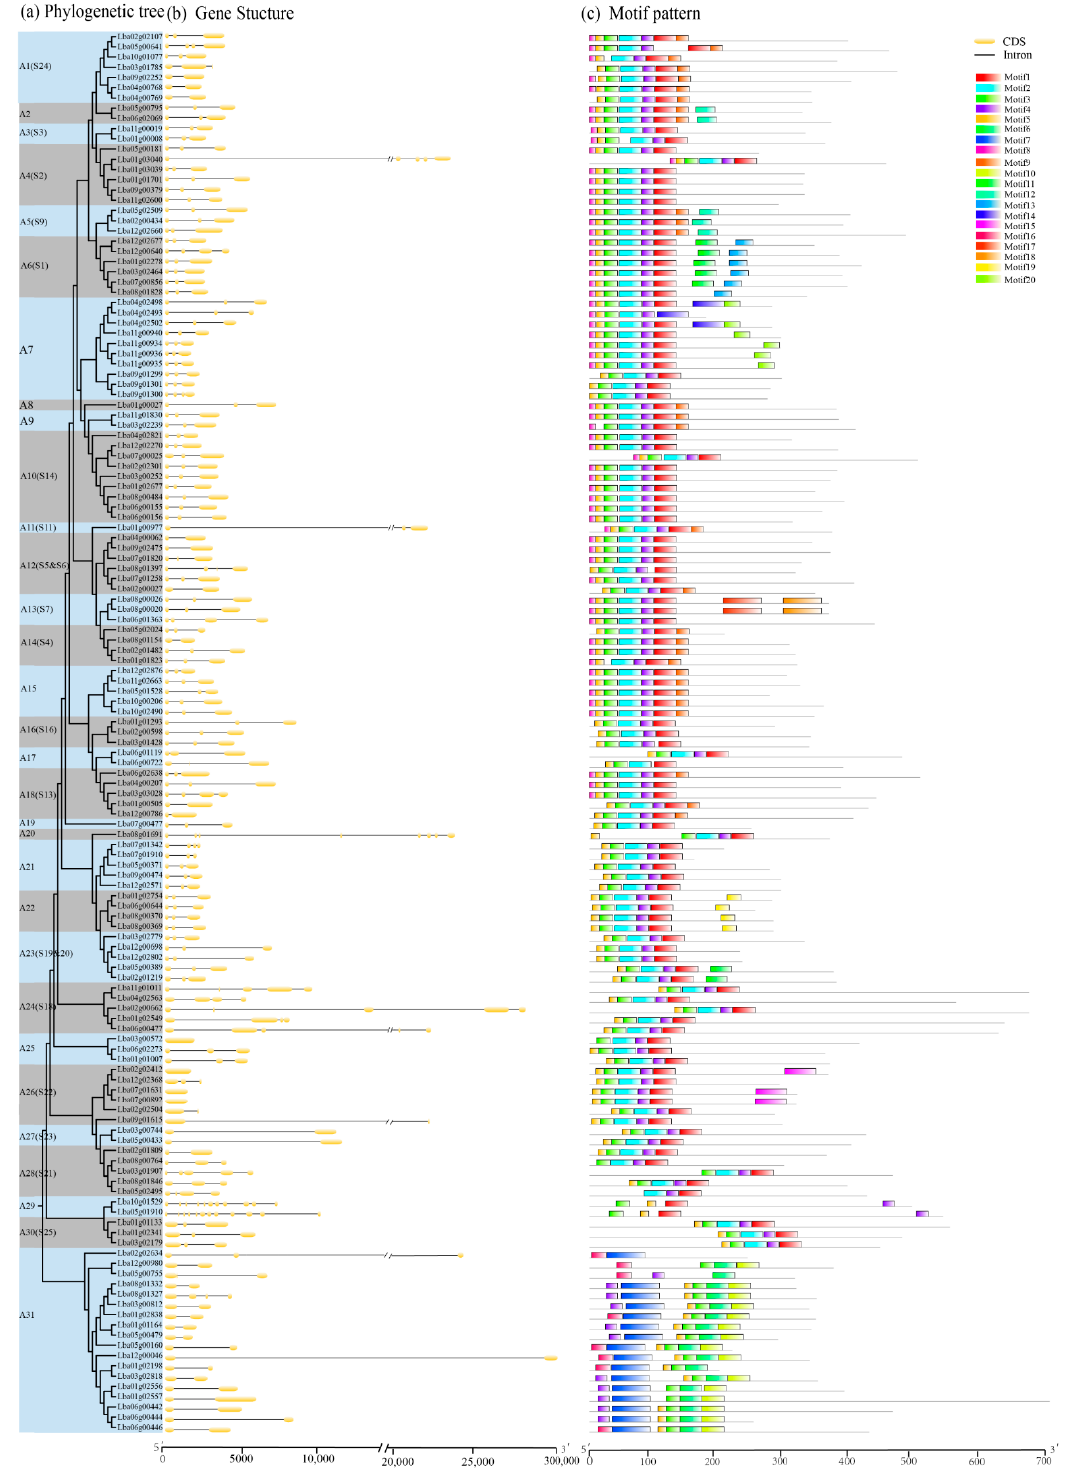
Figure 1. Phylogenetic relationship, conserved protein motifs, and gene structure in LbaR2R3-MYB genes. ( a ) The maximum-likelihood (ML) phylogeny includes 137 R2R3-MYB proteins from wolfberry, grouped into 31 subgroups, sequentially designated as C1 to C31. The corresponding MYB subgroup names in Arabidopsis are also marked. ( b ) Gene structure of wolfberry R2R3-MYB genes. Yellow boxes indicate exons; black lines indicate introns. ( c ) The motif composition of wolfberry R2R3-MYB proteins. Twenty different motifs are displayed in different colored boxes. The length of proteins can be estimated using the scale at the